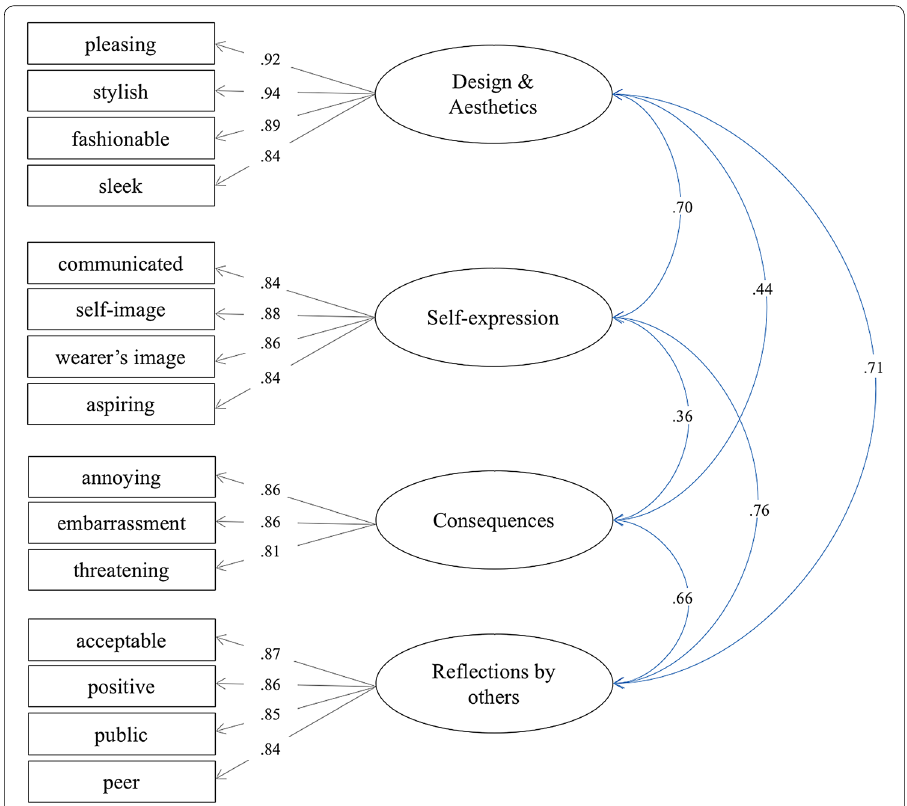
Fig. 2 Final model of refined 4‑dimension WEAR Scale for smart